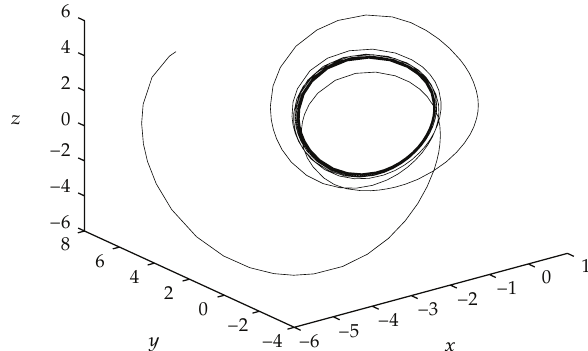
Figure 6: When K (cid:7) − 1 , τ (cid:7) 2, chaos vanishes, and S 2 becomes a stable periodic solution. Here initial value is (cid:3) 5 , − 5 , 5 (cid:4)